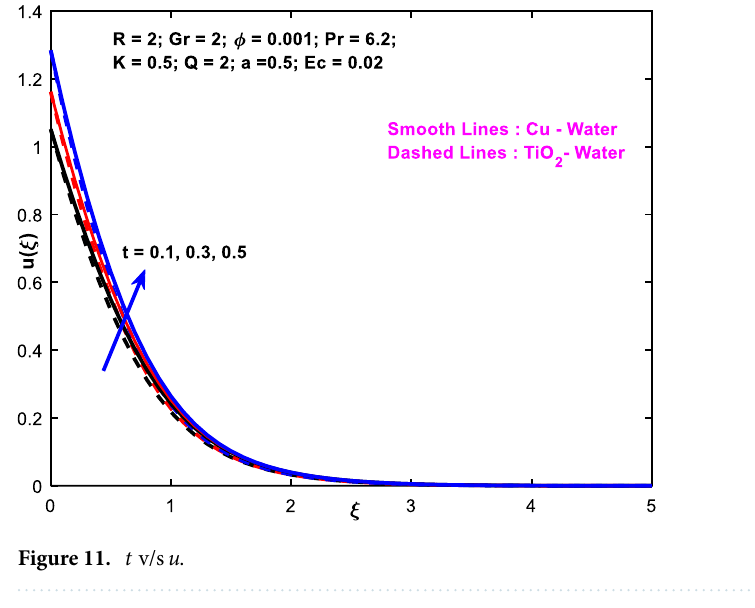
Figure 11. t v/s u .